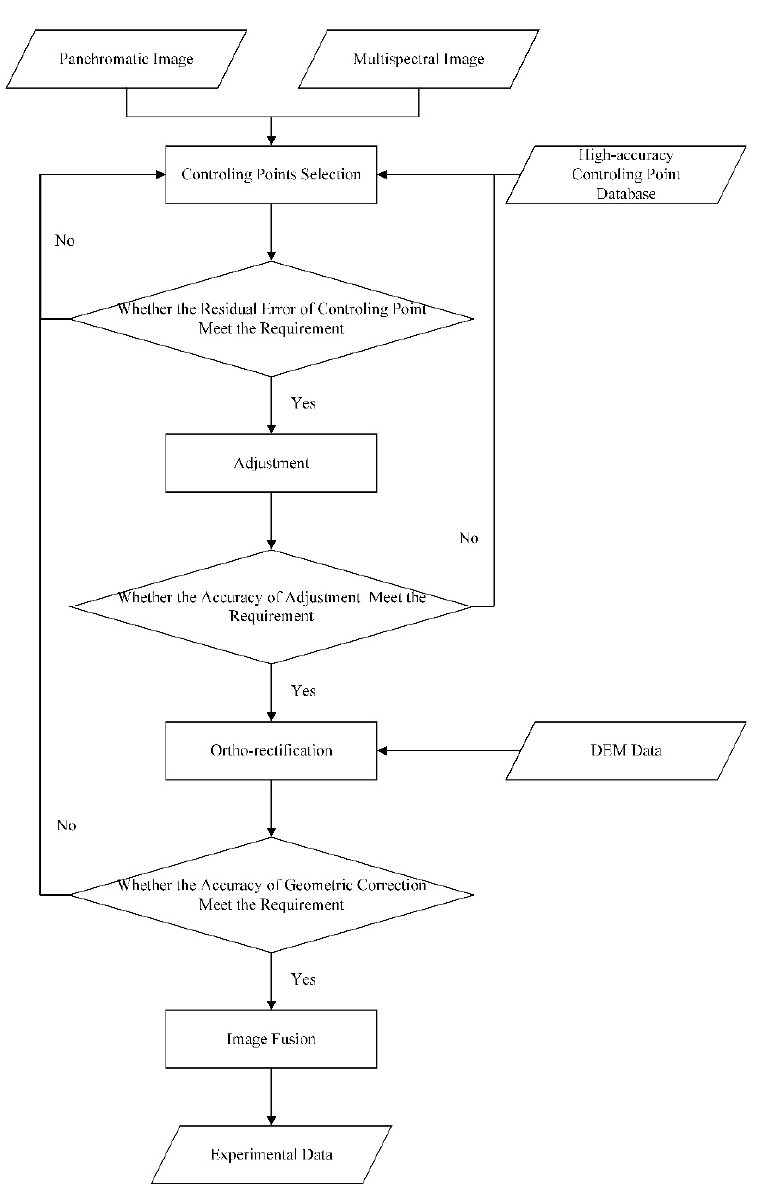
Figure 2. Flow chart of remote sensing image preprocessing.